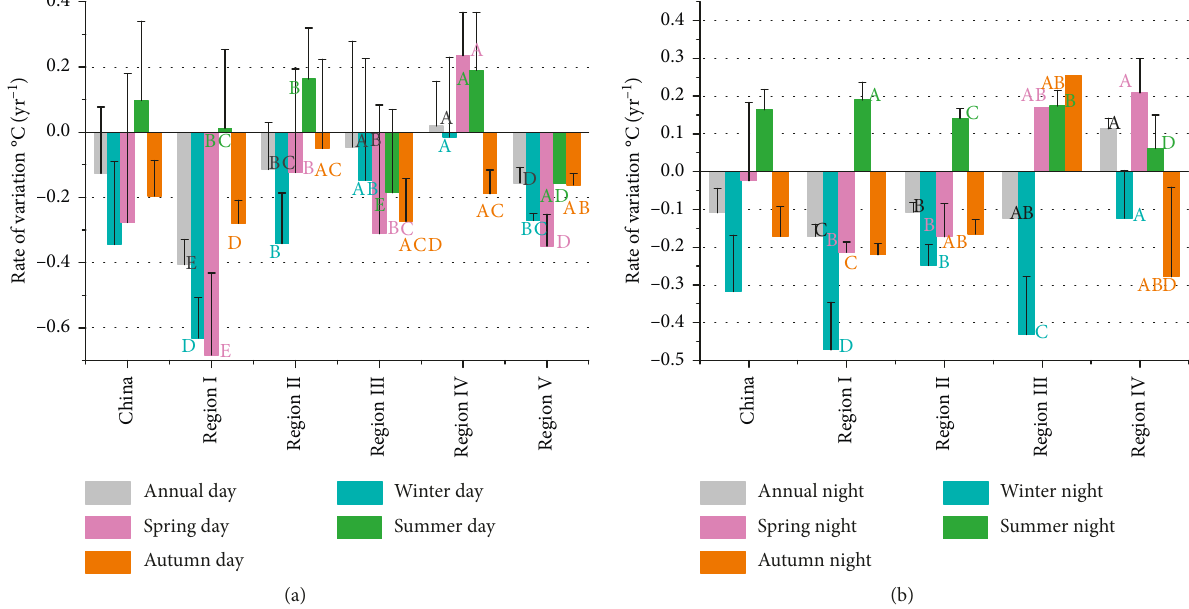
Figure 5: Statistics of the variation rates of mean LSTs in urban regions that significantly changed in the whole year and four seasons during the daytime and night-time from 2003 to 2013 in the five environmental regions of China (A–E represent the mean comparison results among regions, using nonparametric tests of k independent samples; significant differences only existed in rural LSTs among the five environmental regions when the label letters were the